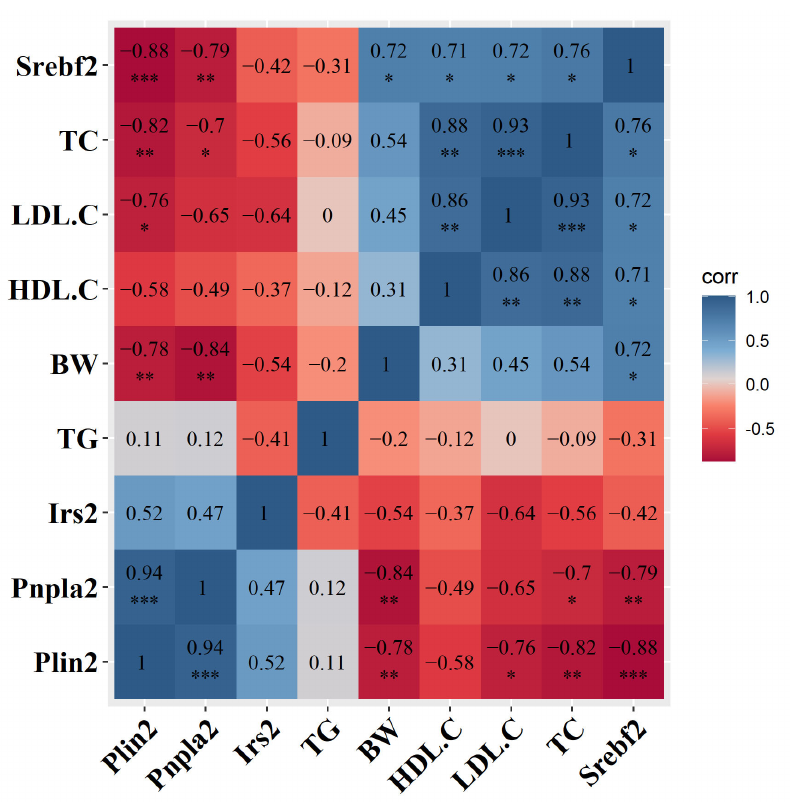
Figure 7. Contour visualization of the interaction between high-fat diet and liver autophagy gene expression and the correlation between clinical indicators. * p < 0.05; ** p < 0.01; *** p < 0.001.